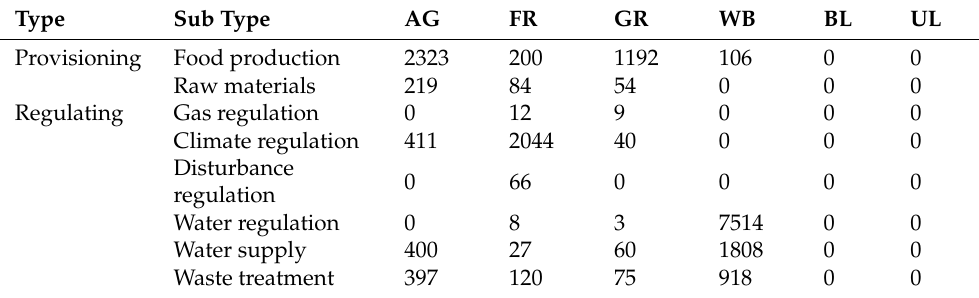
Table 2. The adopted coefficients [22] (US$ ha − 1 yr − 1 ) for an ecosystem service valuation (ESV) of similar LULC types in